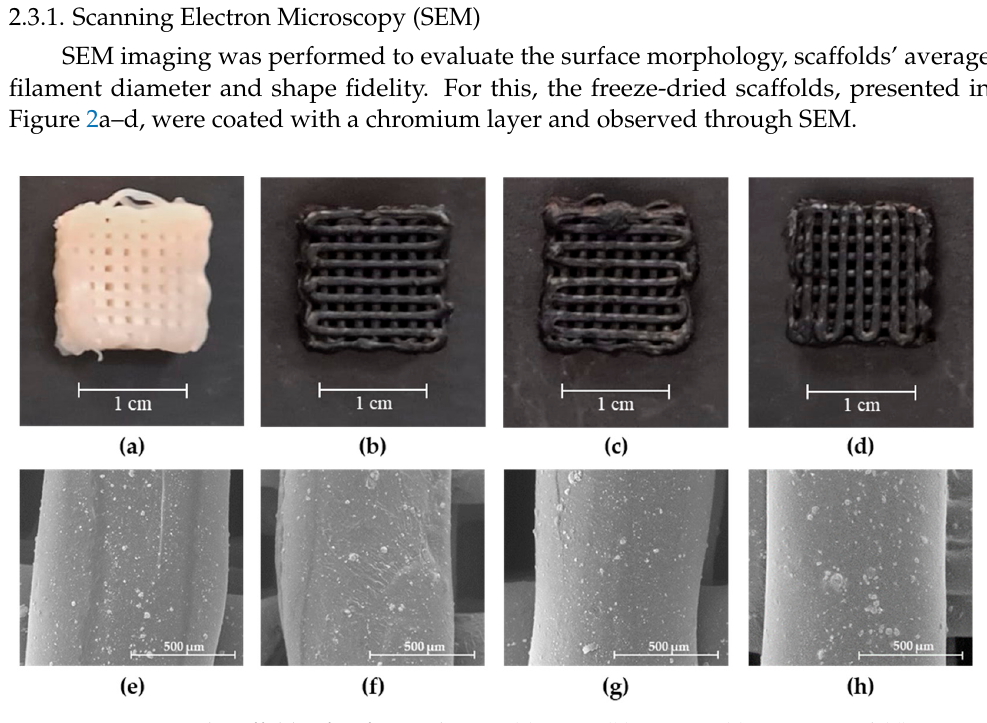
Figure 2. 3D printed scaffolds after freeze-drying: ( a ) P1_B, ( b ) P1_pS1, ( c ) P1_pS3, and ( d ) P1_pS5; SEM images displaying the morphology and shape of the filaments obtained for the 3D printed scaffolds: ( e ) P1_B, ( f ) P1_pS1, ( g ) P1_pS3, and ( h ) P1_pS5. SEM images scale bar: 500 µm.